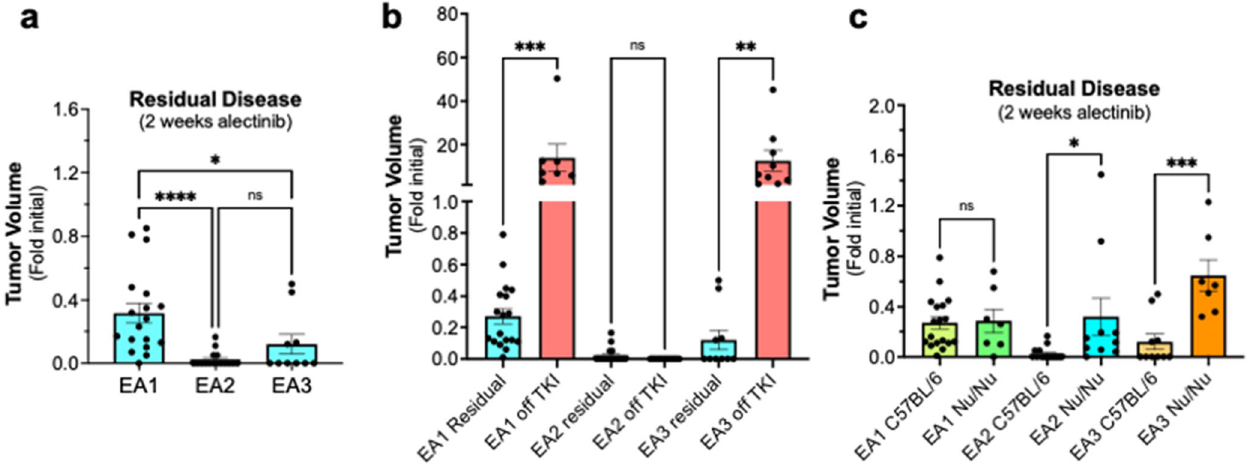
Fig. 3 Distinct DepOR among EML4-ALK models and adaptive immunity requirement for maximal DepOR. a The tumor volumes (fold change from initial) after 2 weeks of alectinib treatment in the EA models (see Fig. 2a) were analyzed by one-way ANOVA (Kruskal – Wallis test). b Tumor-bearing mice treated for 3 weeks with alectinib (Residual, from Fig. 2) were followed by μ CT for another 2 weeks after termination of daily TKI treatment. The tumor volumes relative to initial pre-treatment volumes are presented and the data were analyzed by one-way ANOVA. c The residual disease volumes measured after 2 weeks of alectinib treatment in C57BL/6 were compared to Nu/Nu hosts by two-tail t tests. In the graphs, the error bars are the standard error of the mean and dots represent individual tumors. *, **, ***, and **** indicate p values <0.05, <0.01, <0.001 and <0.0001